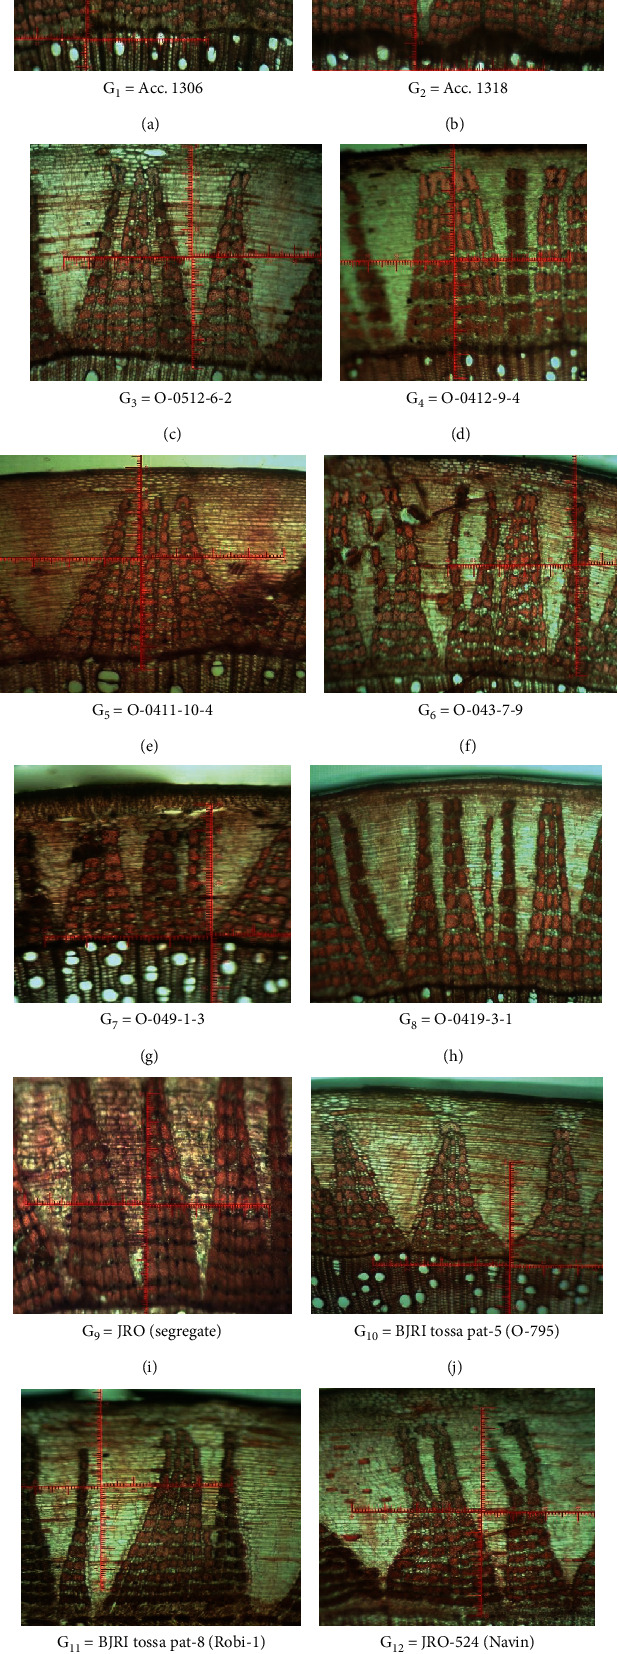
(a–l) Anatomical features of selected 12 tossa jute genotypes at stem base.